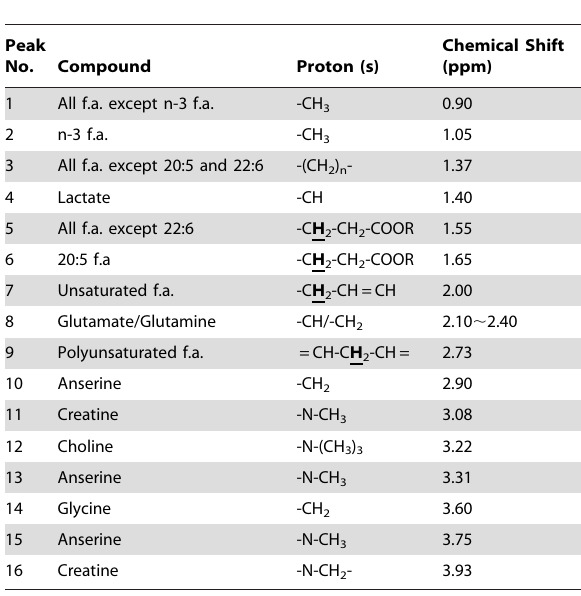
Figure 5. 1 H NMR spectra of intact Siamese algae eater. (A) Sagittal and axial spin-echo images. (B) Conventional 1D spectrum. (C)